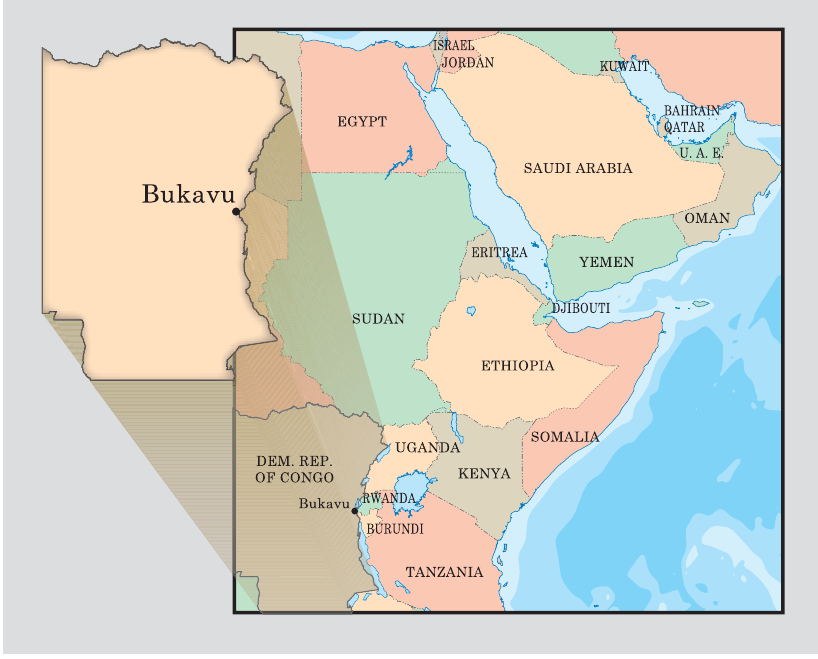
Figure 1. Map of Bukavu, South Kivu,